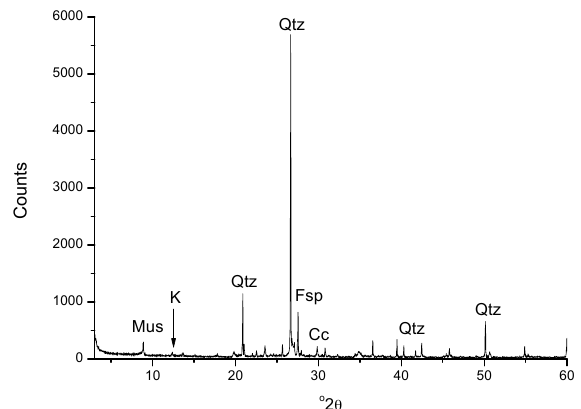
Figure 11. XRD pattern of Sample of area 5 (Mus muscovite, K: kaolinite, Qtz: quartz, Fsp: feldspars, Cc: calcite).